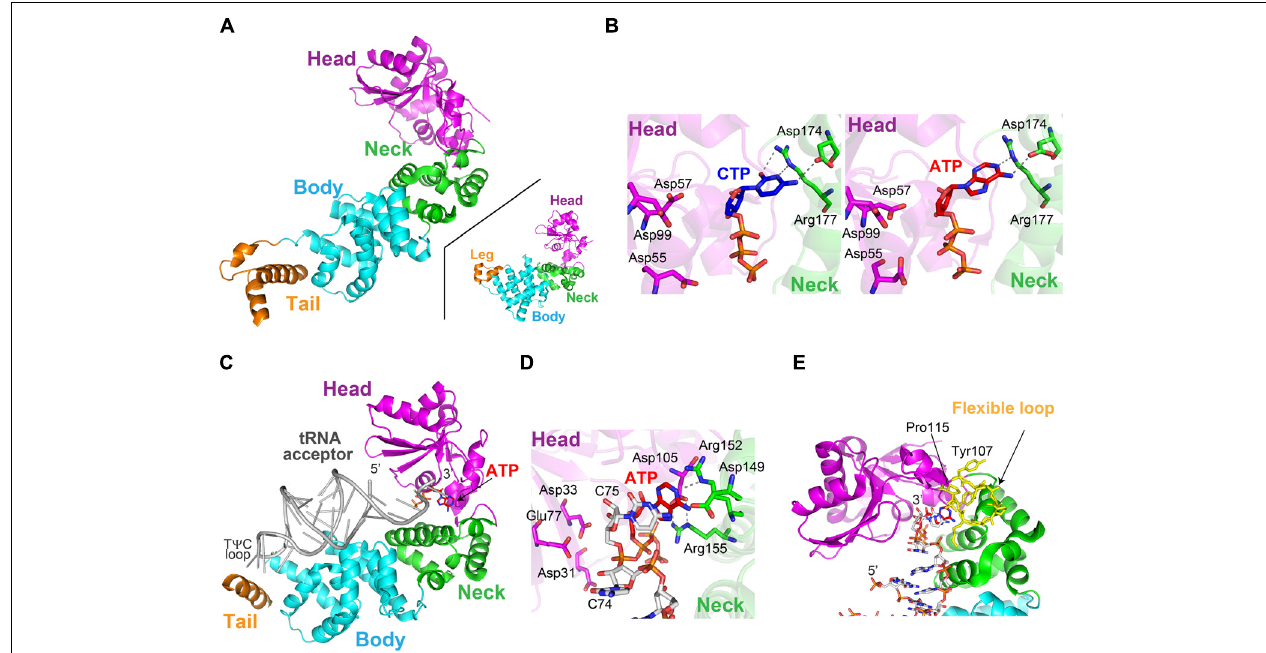
A 76 and an ATP analog. The anticodon region in the structure was disordered. (D) Structure of the catalytic core of AaL, in the presence of a tRNA primer lacking the terminal A 76 and an ATP analog. The ATP analog and the tRNA are depicted by stick models. (E) The flexible loop (colored yellow, amino acid residues 107–115) in the head domain would interact with the 3 (cid:2) -terminal region of the tRNA. The 3 (cid:2) -terminal region of tRNA and the ATP analog in the AaL complex in (C) were modeled onto the structure of TmCCA in (A)